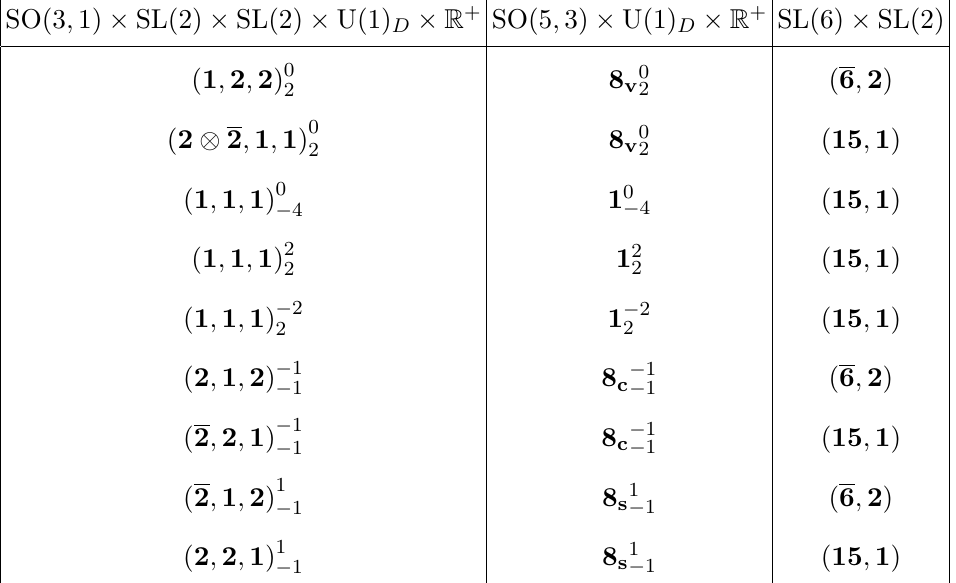
Table 4 . A dictionary relating representations of SL(6) × SL(2) ⊂ E and SO(5 , 3) × U(1) D × 6(6) R + ⊂ E via their common subgroup SO(3 , 1) × SL(2) × SL(2) × U(1) D × R + . We focus on 6(6) the representations appearing in the 27 of E , which under SL(6) × SL(2) decomposes as 27 → 6(6) ⊕ 1 ± 2 ⊕ 8 c − 1 ⊕ ( 15 , 1 ) ⊕ ( 6 , 2 ) , while under SO(5 , 3) × U(1) D × R + decomposes as 27 → 8 v 0 2 2 − 1 8 s 1 ⊕ 1 0 . Under SO(3 , 1) × SL(2) × SL(2) × U(1) D × R + , these representations further decompose − 1 − 4 into the irreducible representations listed in the first column. In the second and third columns, we list the origin of the SO(3 , 1) × SL(2) × SL(2) × U(1) D × R + representations with respect to SO(5 , 3) × U(1) D × R + and SL(6) × SL(2) . In the first and second columns, the subscripts refer to the R + charge, while the superscripts refer to the U(1) D charge. We denote by 2 and 2 the fundamental and complex conjugate representations of SO(3 , 1)